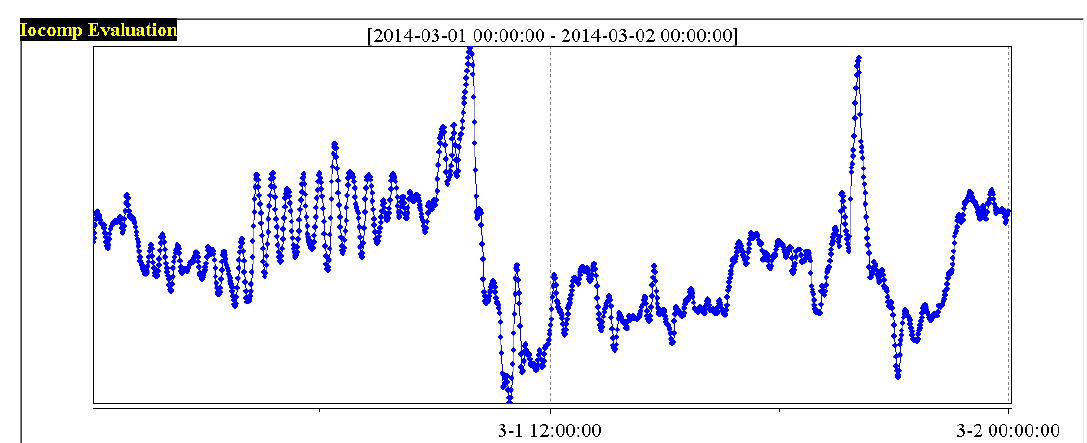
Figure 17. The boiler oxygen content x 3 (%) (2#